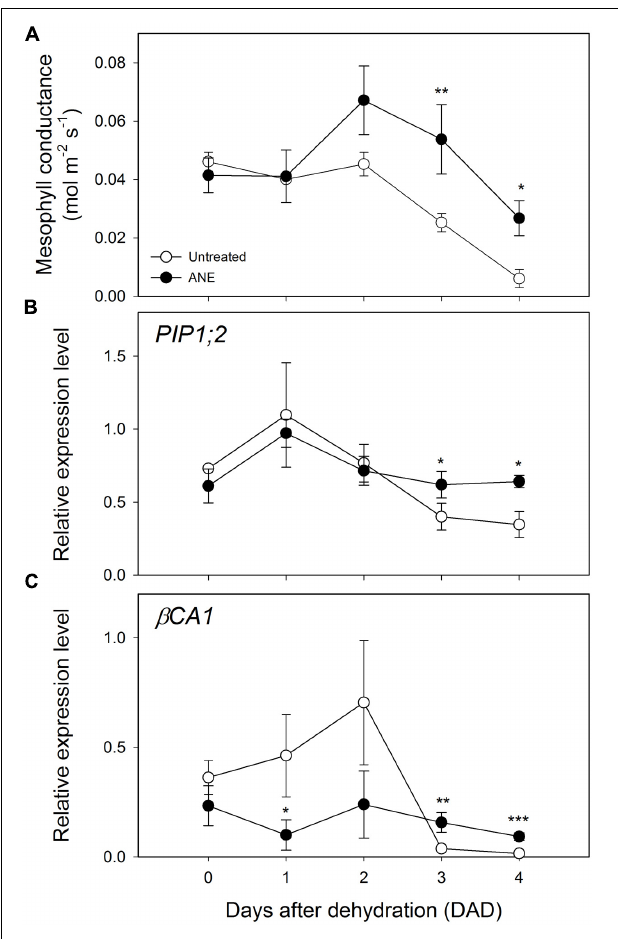
FIGURE 4 | Modulation of mesophyll conductance and expression pattern of genes involved in CO 2 diffusion from the sub-stomatal cavities to the carboxylation sites. Time 0 is the dehydration stress starting time and it corresponds exactly with the last day of Ascophyllum nodosum extract (ANE) treatment. Data of mesophyll conductance (A) during 4 days after dehydration (DAD). Each dot shows the mean ± SE of nine biological replicates. Data of expression level analysis of PIP 1;2 (B) and β CA1 (C) , during four DAD. Each dot shows the mean ± SE of four biological replicates. Untreated (white dot) and ANE treated (black dot) samples were analyzed by one-way ANOVA ( P < 0.05), ∗ P ≤ 0.05; ∗∗ P ≤ 0.01; ∗∗∗ P ≤ 0.001.